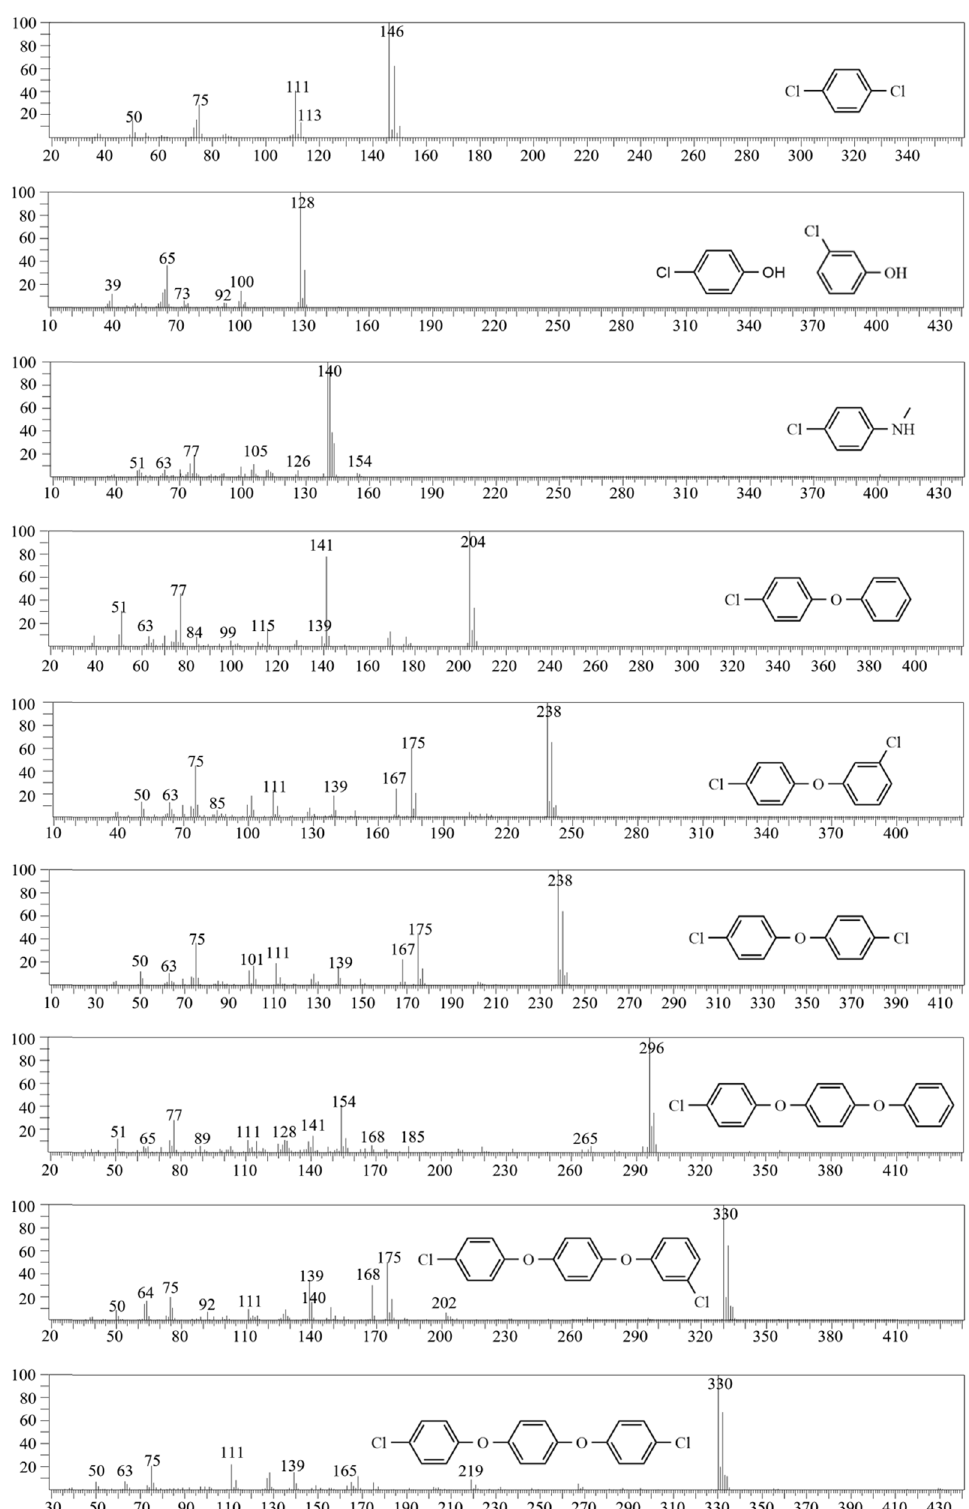
Figure A2: The GC - MS detection results of low - polar